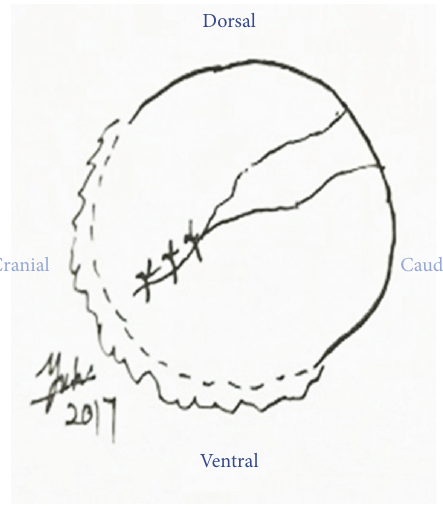
Figure 9: Inner and outer muscular layer were sutured by 2.0 PDS in interrupted suture pattern.